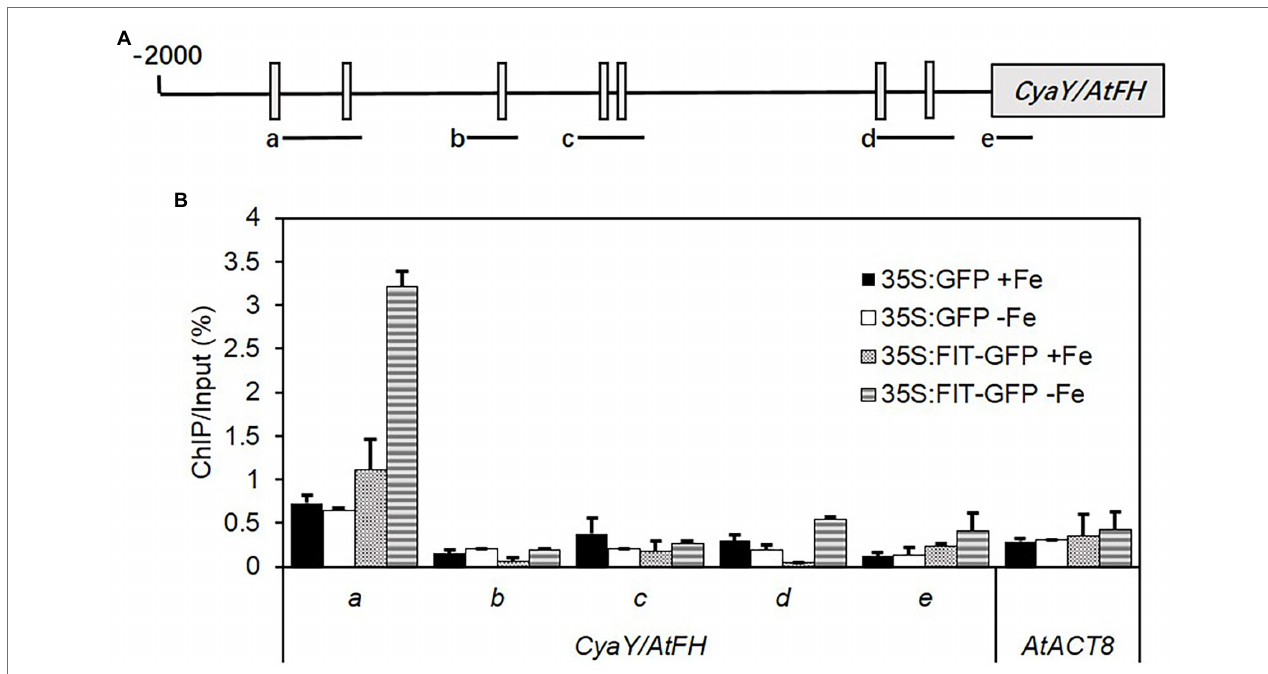
FIGURE 5 | ChIP-qPCR analysis of the binding of FIT to the promoter of AtFH . Chromatin was extracted from 35S:FIT-GFP and 35S:GFP seedlings after administration of low iron stress for 7 days, and then precipitated using anti-GFP antibody. Precipitated DNA was amplified with primers corresponding to the different sequence regions of the AtFH promoters. (A) The ChIP signal obtained from multiple-quantitative ChIP-PCR was quantified as the percentage of total input DNA. (B) Three biological replicates were performed. Standard deviations were calculated from three technical repeats. Letters a–d indicate the amplified fragments from the promoter region of AtFH , respectively. ACTIN8 was used as a negative